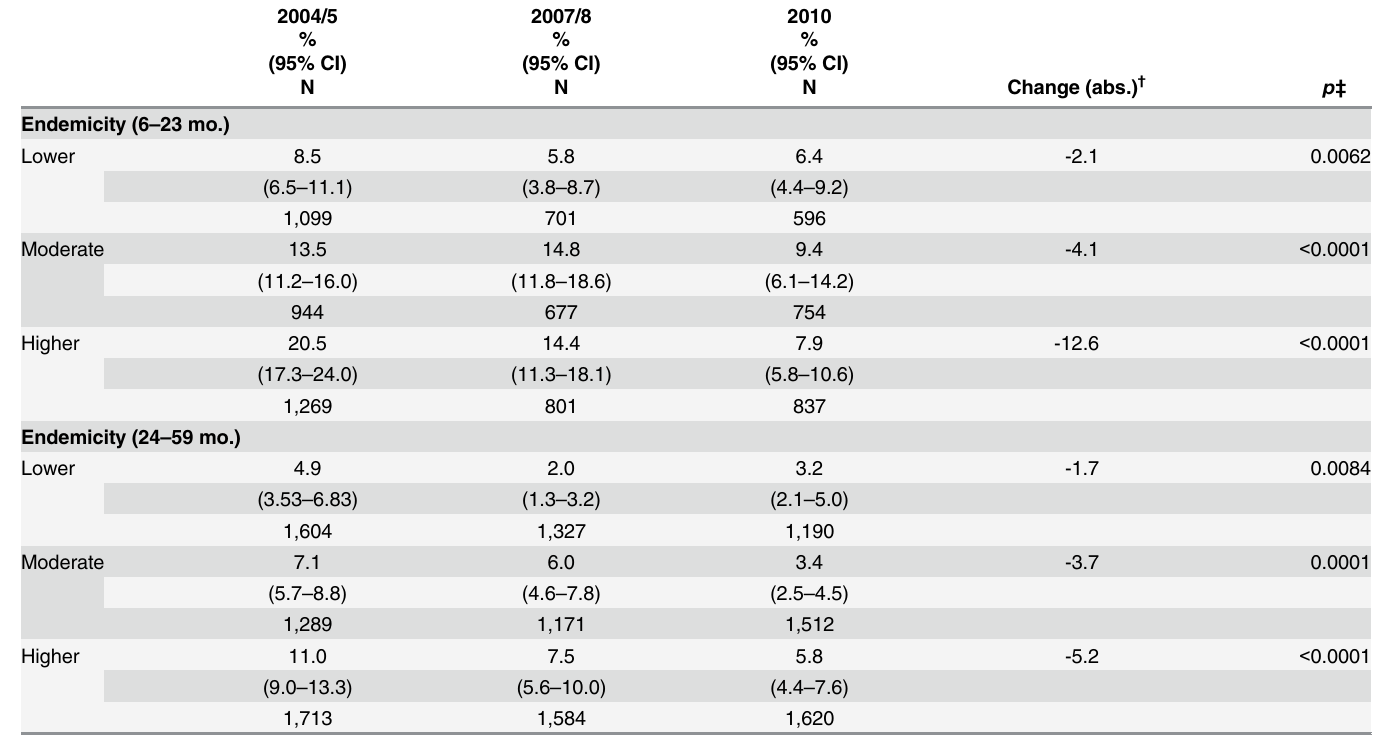
Table 2. Trends in severe anemia prevalence stratified by malaria endemicity * levels and age in Mainland Tanzania,